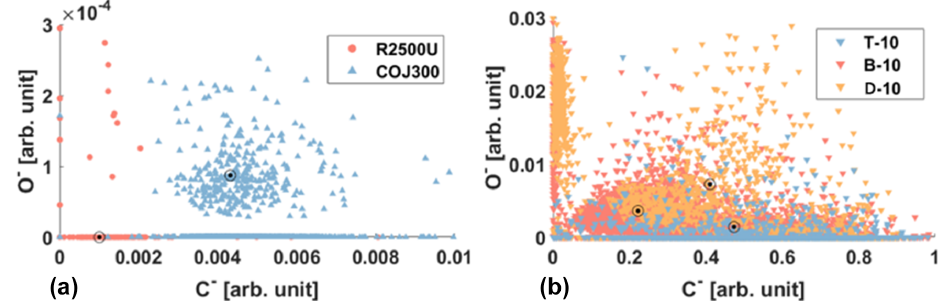
Figure A1. Negative polarity oxygen and carbon peak areas from PALMS for (a) 400nm R2500U and COJ300 BC. (b) SOA-coated BC particles. Cluster centroid denoted as a bull’s eye. Generally, the probability of O − signal presence in COJ300 is an order of magnitude higher than R2500U.